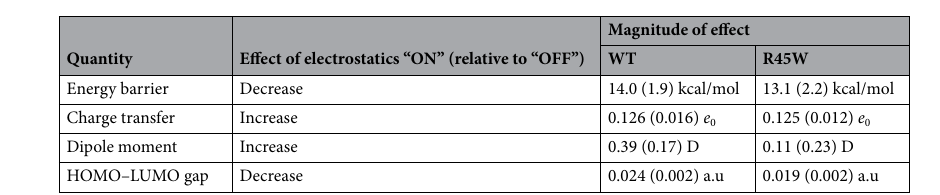
Table 1. Effect of the presence (as compared to the absence) of the electrostatic environment of the enzyme on some parameters relevant for catalysis, calculated for WT MAO-A and the R45W mutant (standard error of the mean values are given in